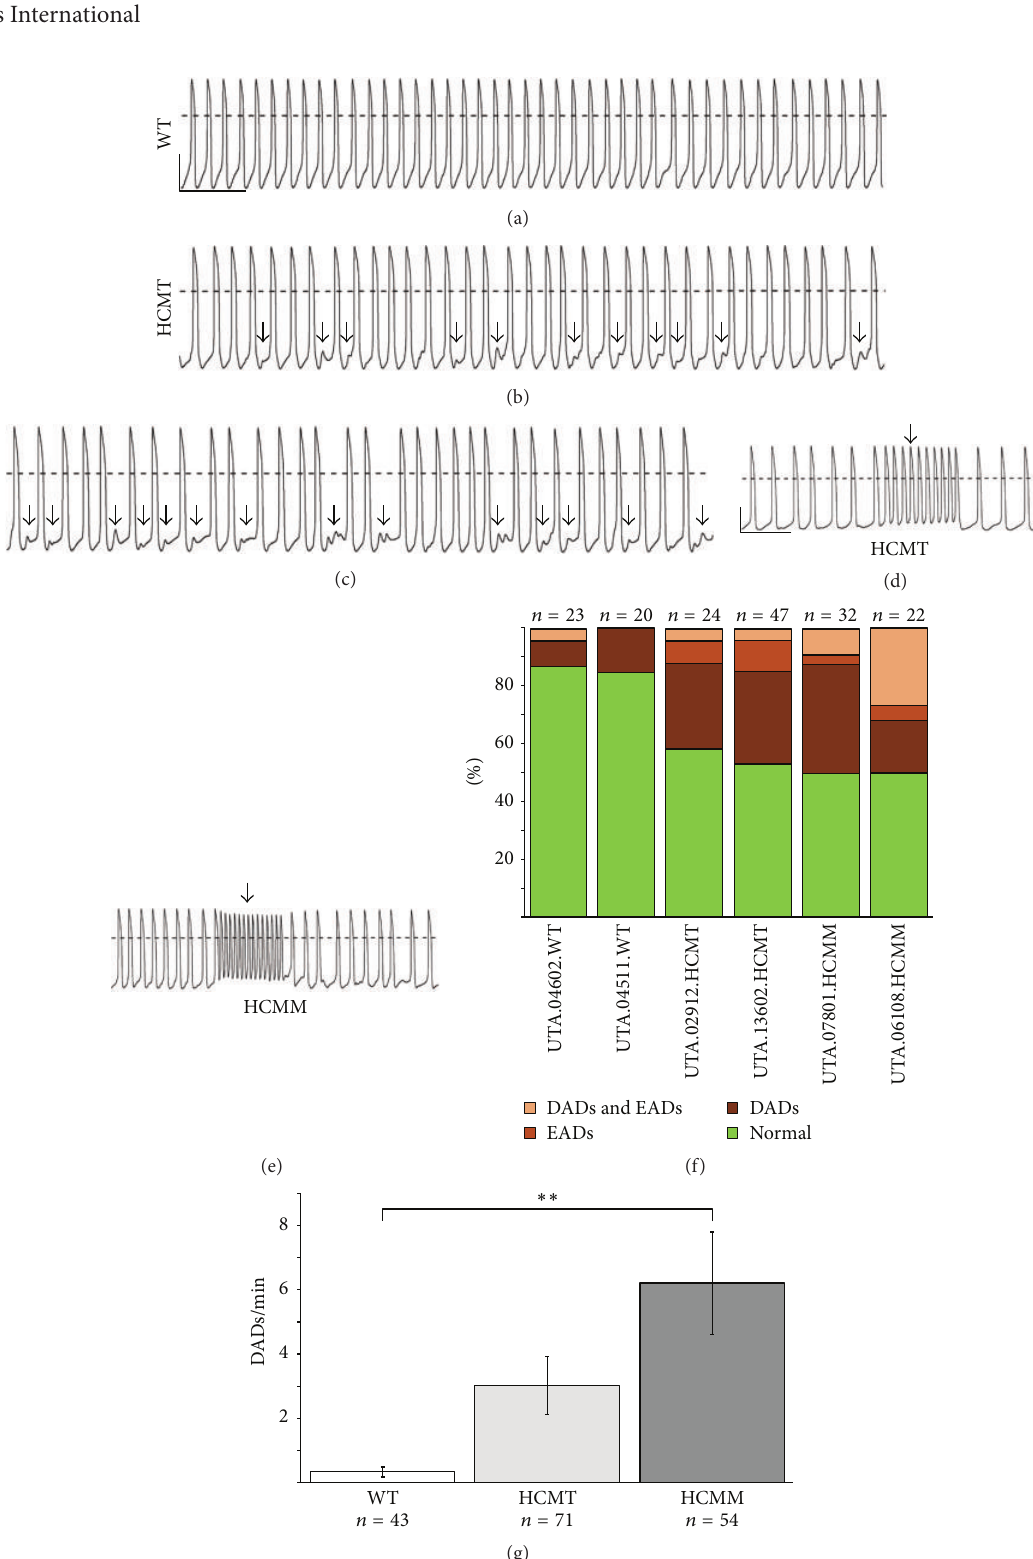
Figure 3: Arrhythmogenic events (DADs and EADs) were observed in HCM-CMs. (a)–(e) Representative recordings of control hiPSC- derived CMs (WT) and hiPSC-derived CMs carrying TPM1-Asp175Asn (HCMT) or MYBPC3-Gln1061X (HCMM) mutations. Typical DADs (arrows) are presented in (b) and (c) and EADs (arrows) in (d) and (e) for HCMT-CMs and HCMM-CMs, respectively. Scale bars represent 40 mv and 5 seconds, respectively. Scale bars in (a) are representative for (b) and (c), and scale bars in (d) are representative for (e). (f) Distribution of CMs exhibiting arrhythmogenic events in each cell line. (g) DAD rate was significantly higher in HCMM-CMs than in WT- CMs ( ∗∗ 𝑝 < 0.005